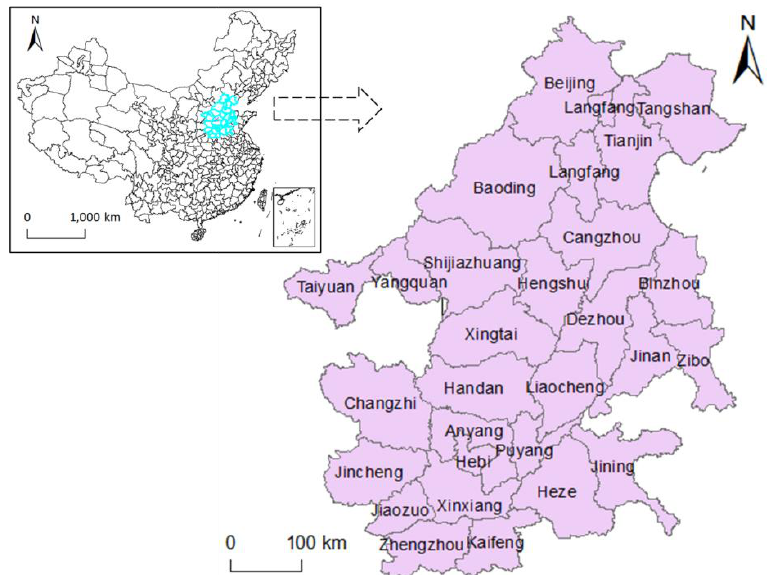
Figure 1. The location of Beijing-Tianjin-Hebei region and surrounding areas.